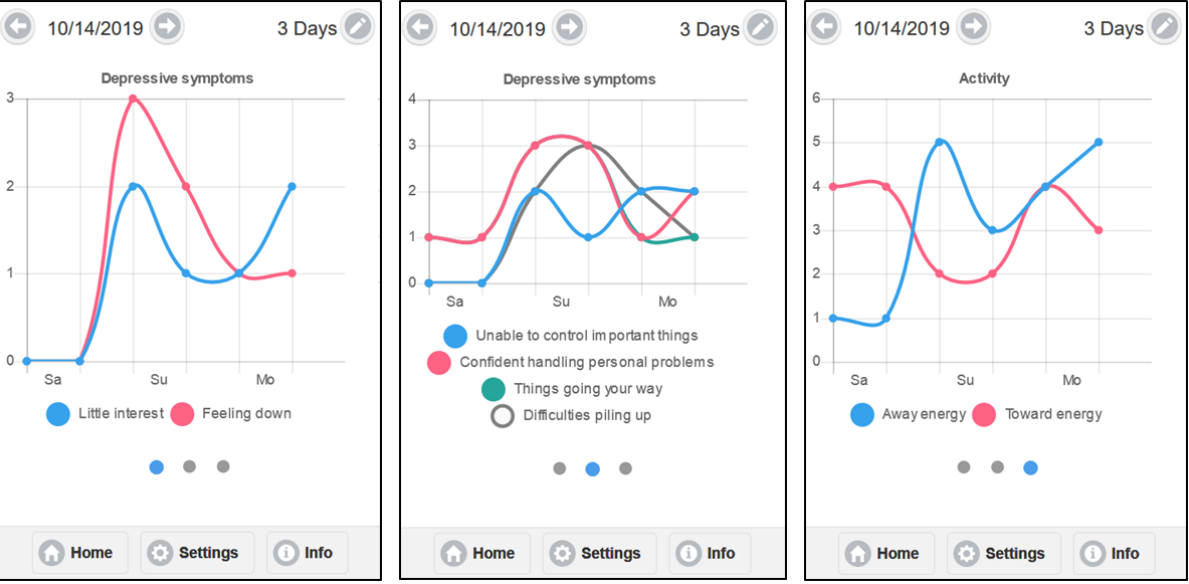
Figure 4. Visualize function of the Lorevimo app. The images represent screenshots of the Lorevimo app’s Visualize function. The first image (left) is a representation of the depressive symptoms in a 3-day (twice daily) interval. The second image (center) conveys the perceived stress symptoms (also a 3-day interval). The final image (right) reflects the responses to the question about energy consumed by avoidance behaviors (ie, away from internal experiences) or values-based behaviors (ie, toward who or what